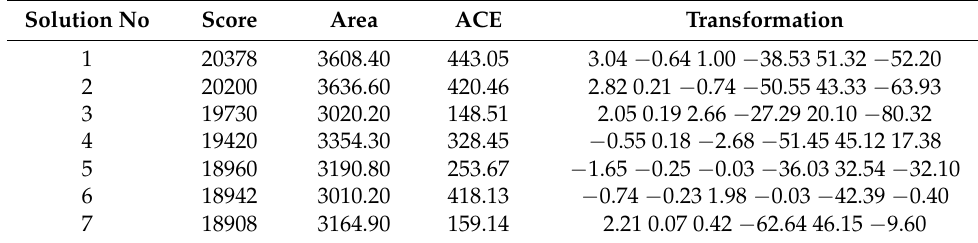
Table 9. Vaccine solutions docked for the top 20 TLR4